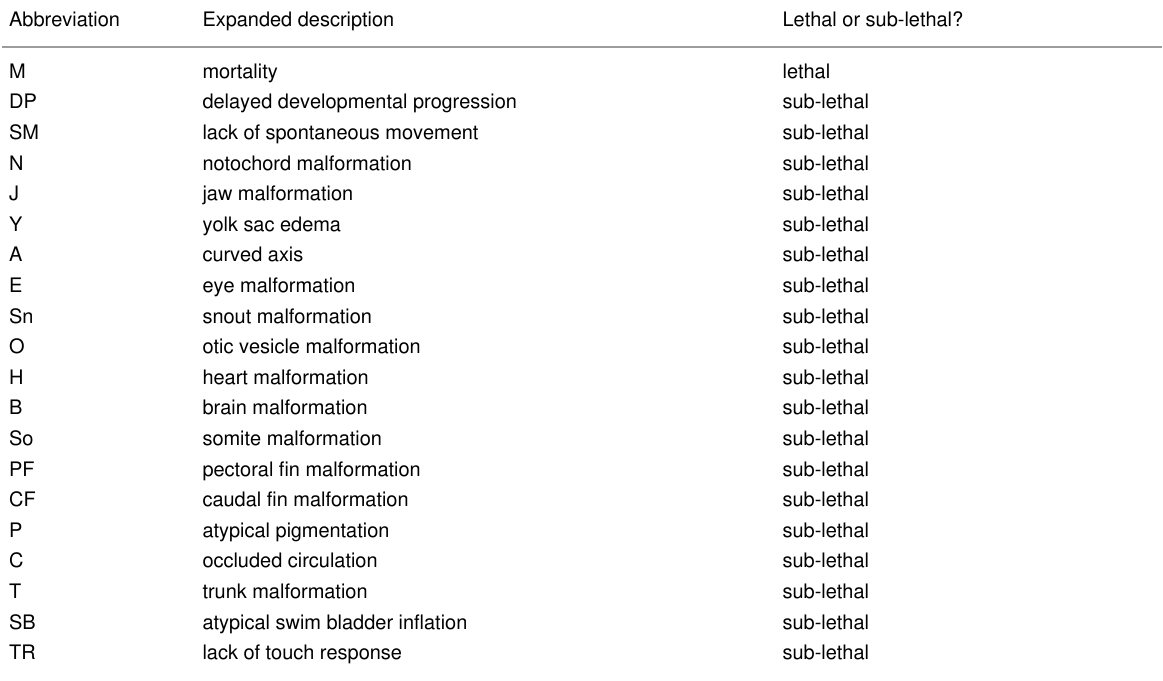
Table 2: Abbreviations used to label the different endpoints corresponding to different biological changes observed at either 24 and/or 120 hours post-